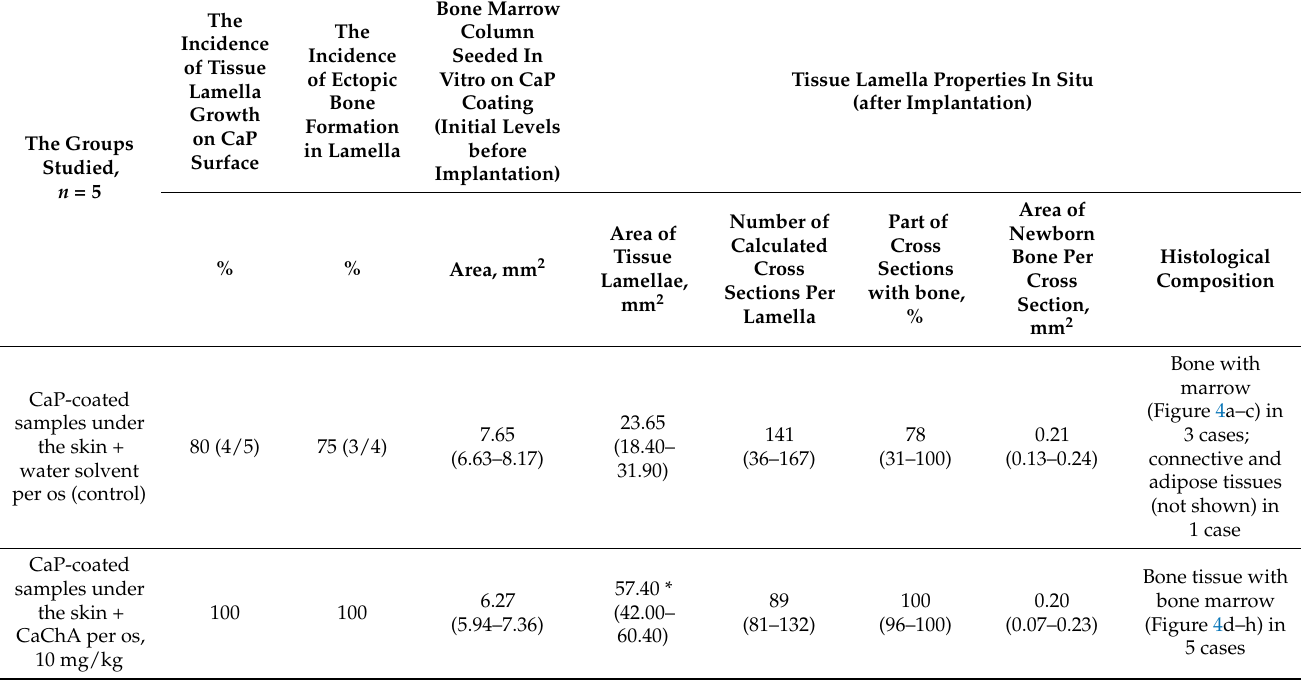
Table 3. Effect of CaChA in vivo administration on the tissues growing subcutaneously on CaP-coated Ti substrates after 45 days of the ectopic test in mice, Me (Q1;